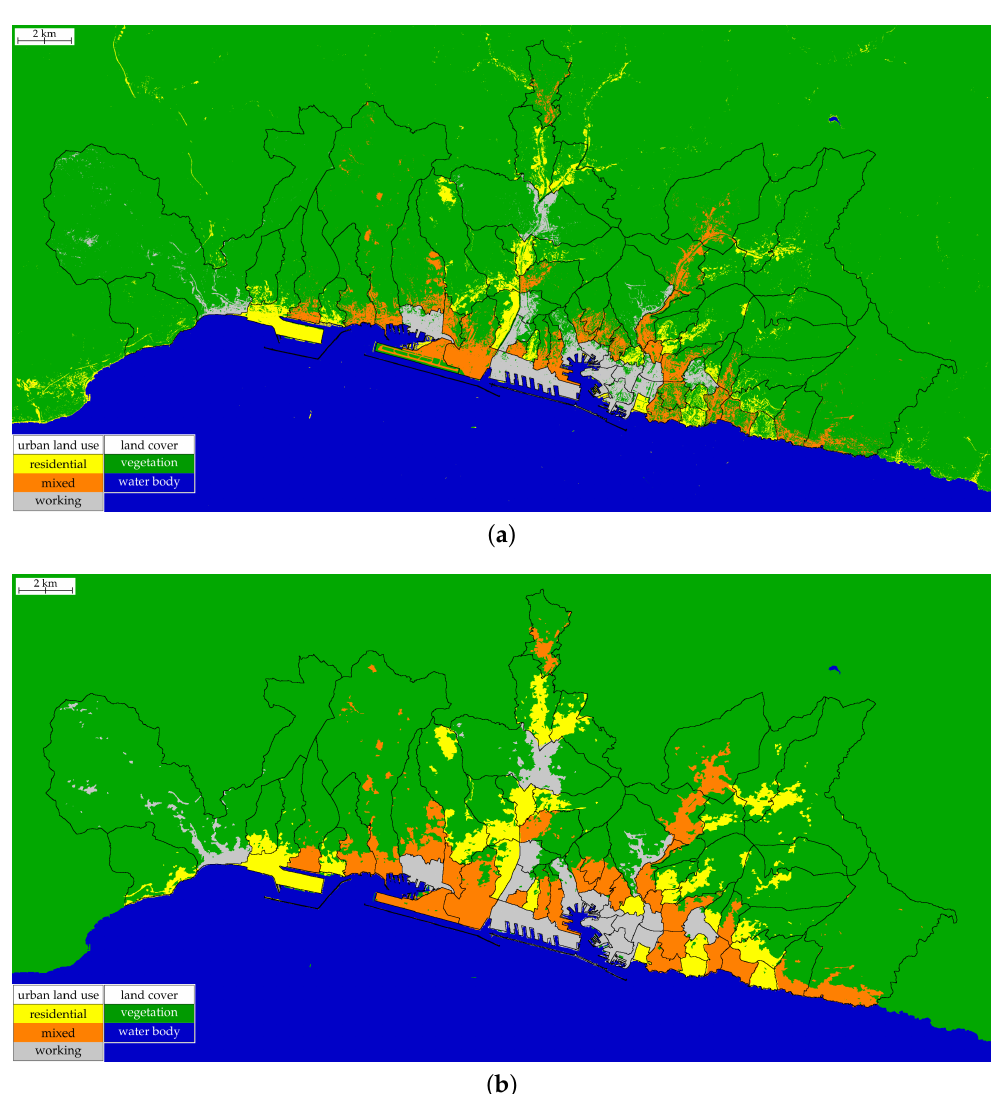
Figure 10. Urban land-use and land-cover maps generated by ( a ) the proposed pixelwise decision fusion method and ( b ) the proposed Markovian region-based multiscale